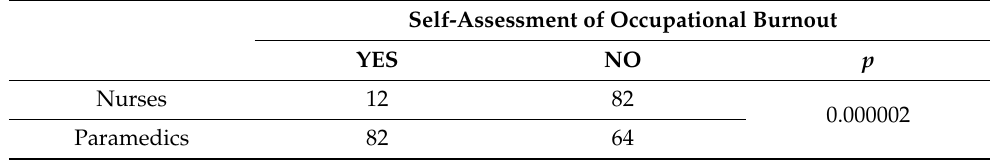
Table 6. The correlation between self-reported burnout of paramedics and nurses.